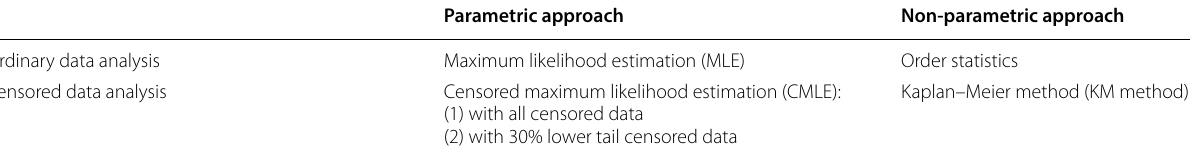
Table 1 Statistical analysis on censored datasets